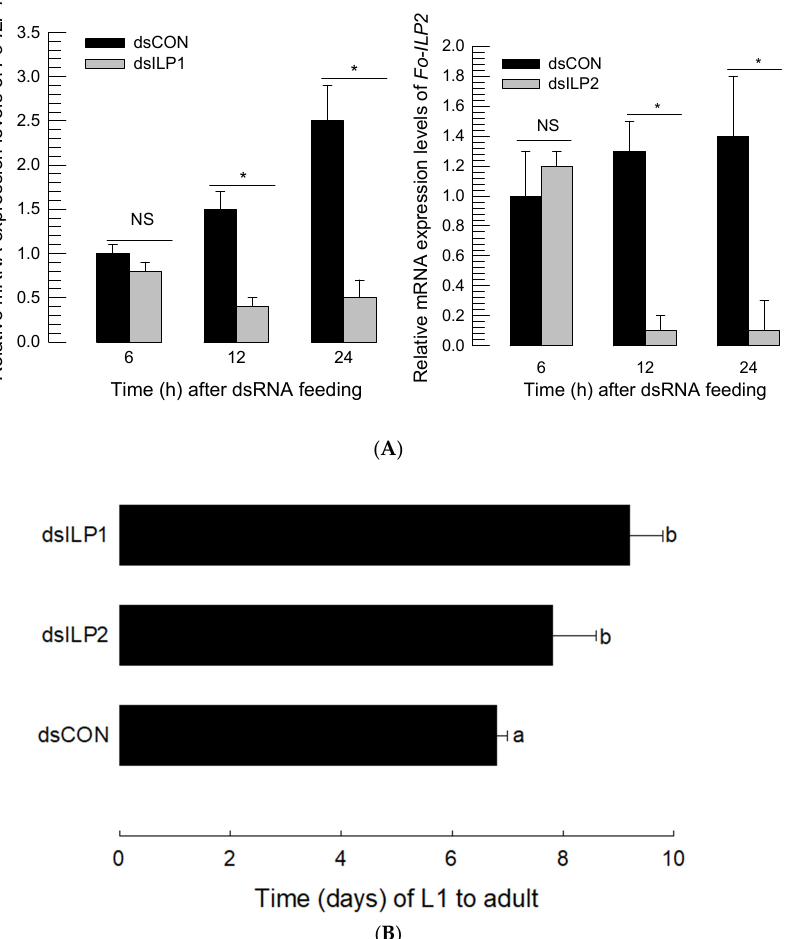
Figure 3. Effects of RNA interference (RNAi) of ILP expression on the immature development of F. occidentalis . RNAi was performed by feeding dsRNA specific to each ILP gene of F. occidentalis . ( A ) RNAi efficacy measured by mRNA levels using RT-qPCR. Each treatment used 25 individuals for cDNA preparation and was independently replicated three times. The asterisks above the standard deviation bars indicate significant differences between two treatments at type I error = 0.05 (LSD test). ‘NS’ stands for no significant difference. ( B ) Change in the immature developmental period from egg hatching (L1) to adult emergence by the RNAi treatments. ‘dsCON’ represents dsRNA specific to EGFP , which is a nontarget gene. Each treatment used 30 individuals to measure their developmental periods. The letters above the standard deviation bars indicate significant differences among the means at type I error = 0.05 (LSD